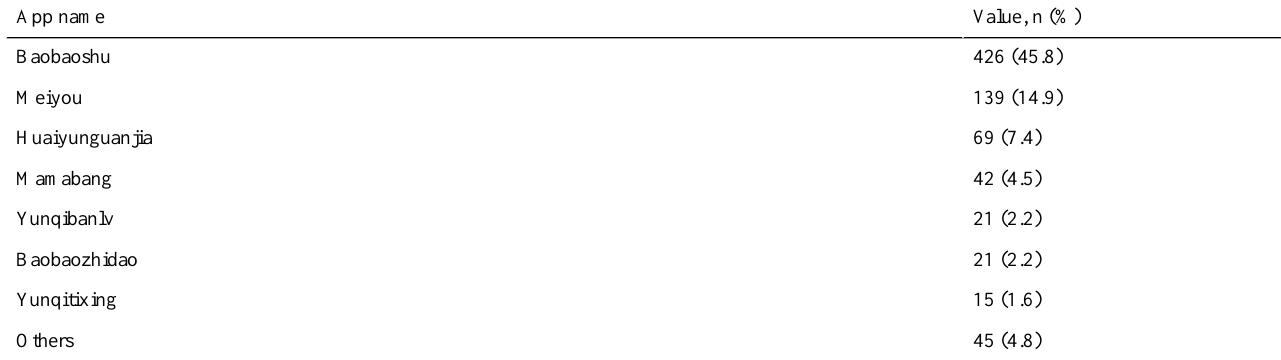
Table 4. Common antenatal care apps.